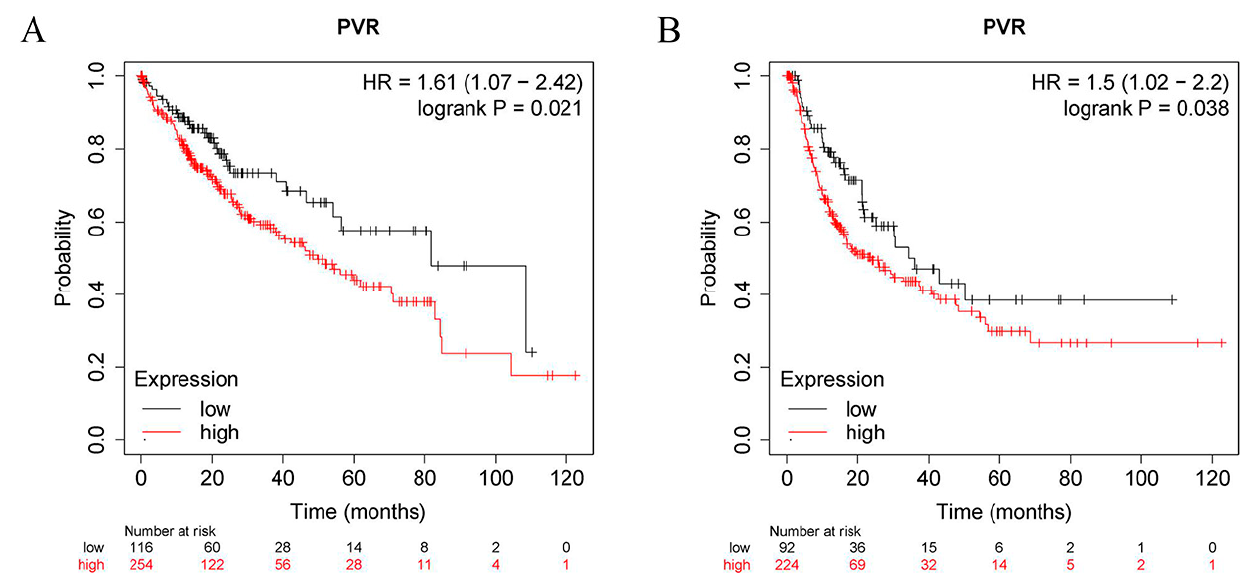
Figure 3. PVR has prognostic value in HCC. ( A ) OS between the high PVR group and low PVR group. ( B ) RFS between the high PVR group and low PVR group.